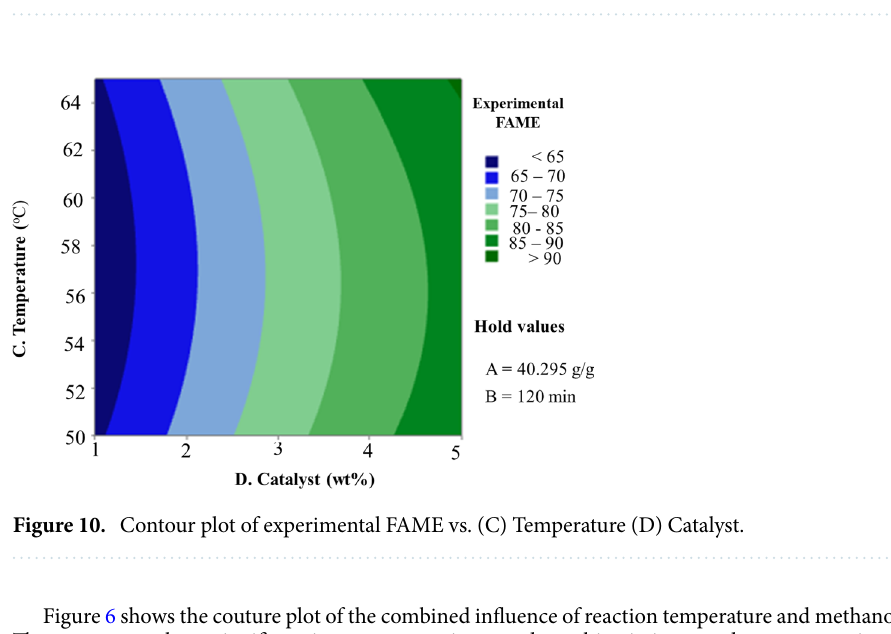
Figure 9. Contour plot of experimental FAME vs. (B) Time (D) Catalyst.